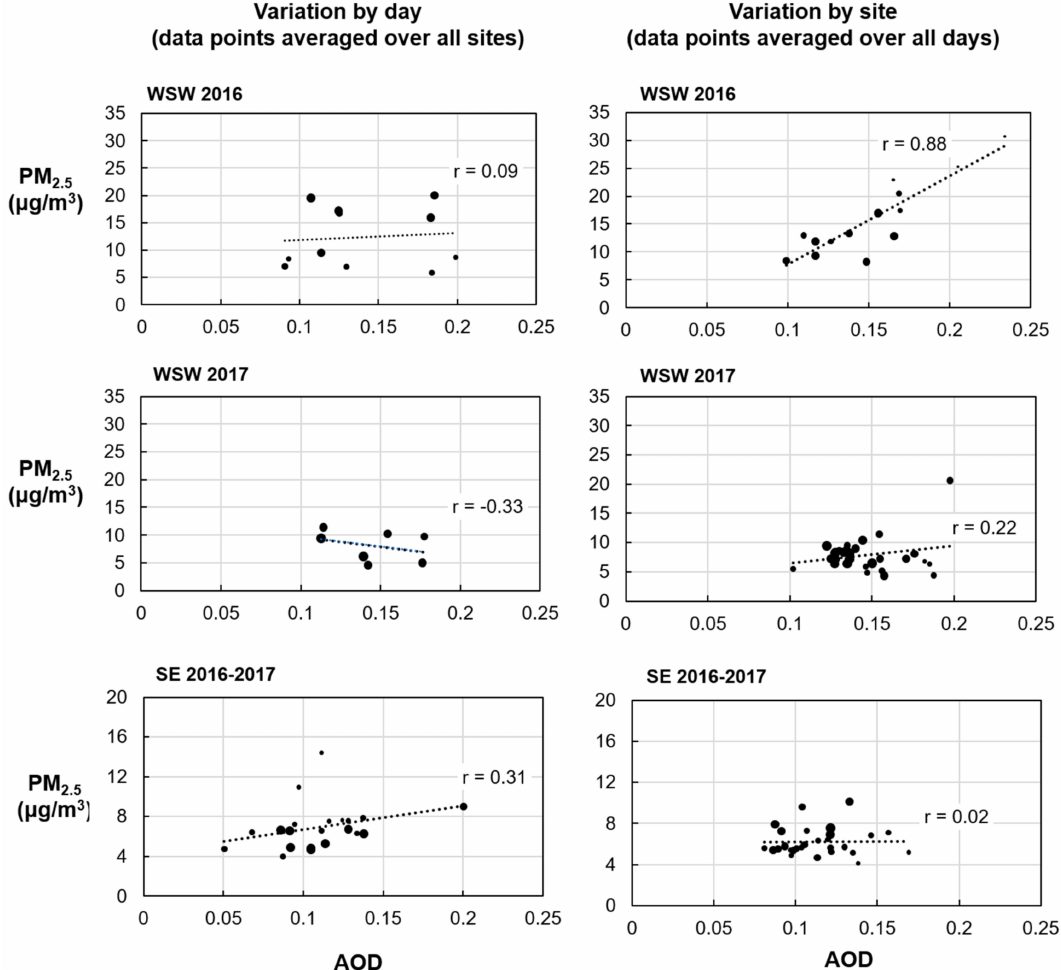
Figure 11. Scatterplots of paired AOD vs. IVAN PM2.5 site and day averaged. Left panels are site averaged to highlight temporal variability across the days comprising sets. Right panels are day averaged to highlight spatial variability across sites comprising sets; ( top ) 2016 WSW, ( middle ) 2017 WSW, and ( bottom ) SE 2016 to 2017. Symbols sized according to the number of paired AOD-PM samples per data point: 7 to 11 sites and 1 to 11 days (WSW 2016); 16 to 26 sites and 2 to 7 days (WSW 2017); 5 to 26 sites and 1 to 22 days (SE 2016 to